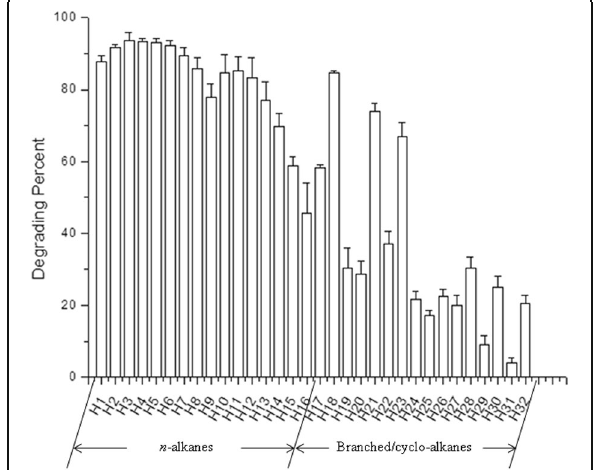
Fig. 3 Degrading rates of crude oil by P. steynii DX4. H1 - H16: